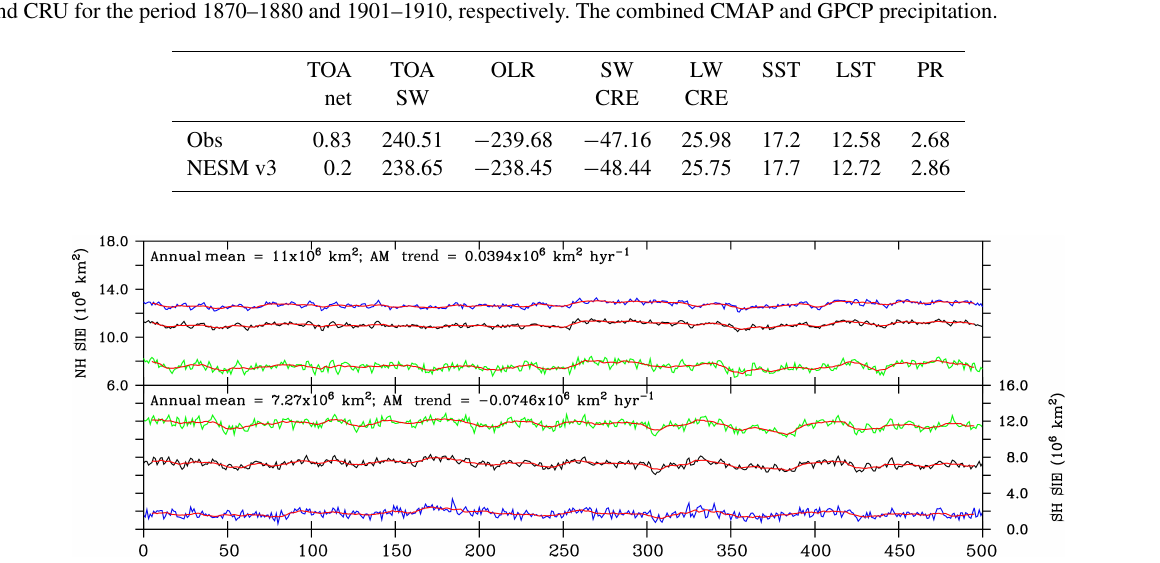
Table 1. Summary of the global averaged annual mean values for radiation, temperature, and precipitation compared to observations. The observed energy estimations are from CERES ed2.8 for the period 2001–2014. The observed SST and LST data are derived from Hadley SST and CRU for the period 1870–1880 and 1901–1910, respectively. The combined CMAP and GPCP precipitation.